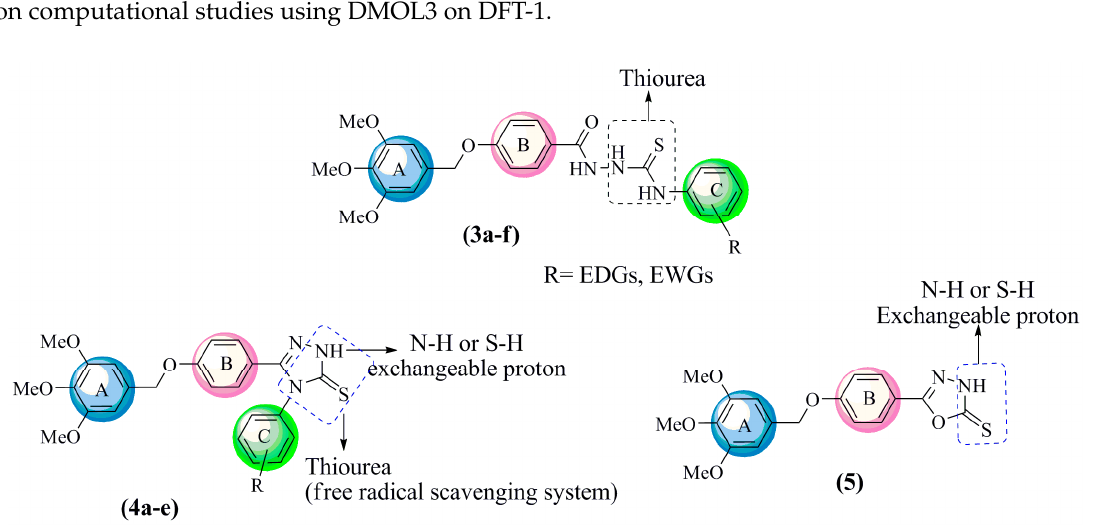
Figure 1. SAR analysis of 1-arylthiosemicarbazides 3a – f , 1,2,4-triazoles 4a – e and 1,3,4-oxadiazole 5